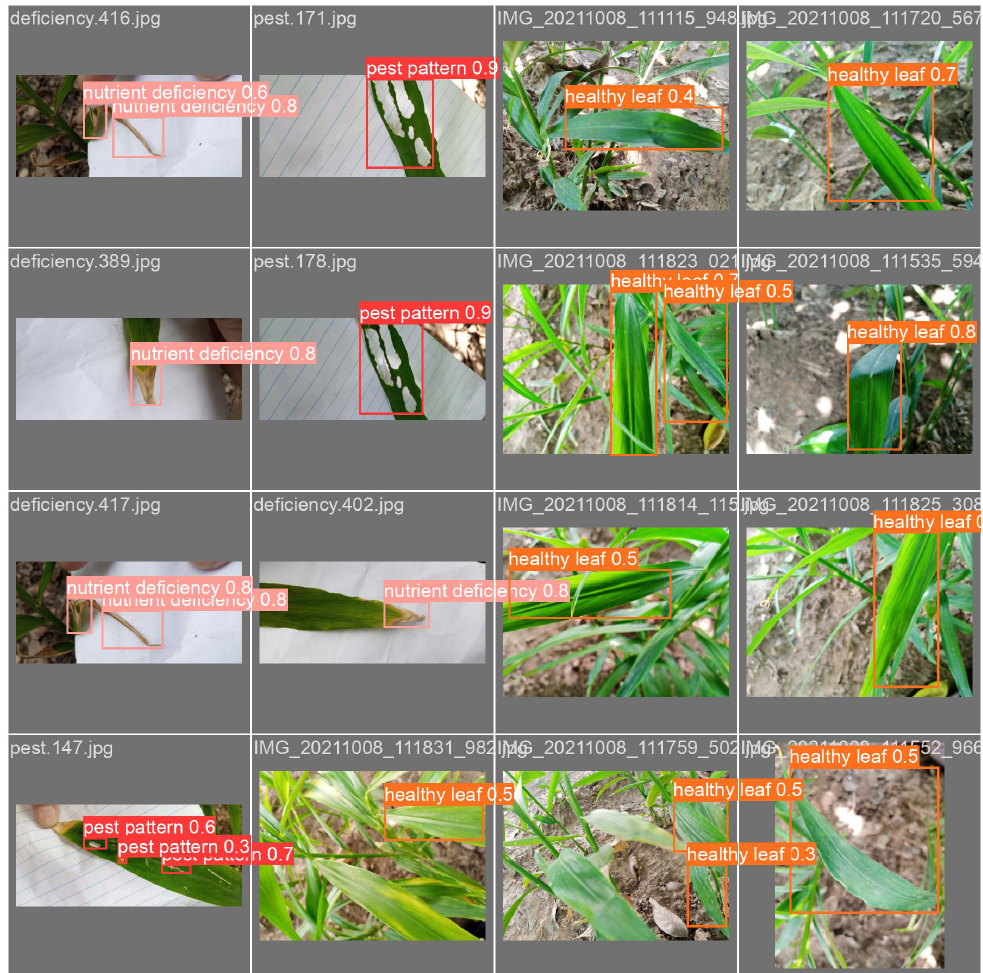
Figure 21. Set 1 of visual examples showcasing the qualitative evaluation of the YOLOv5 model on ginger dataset.